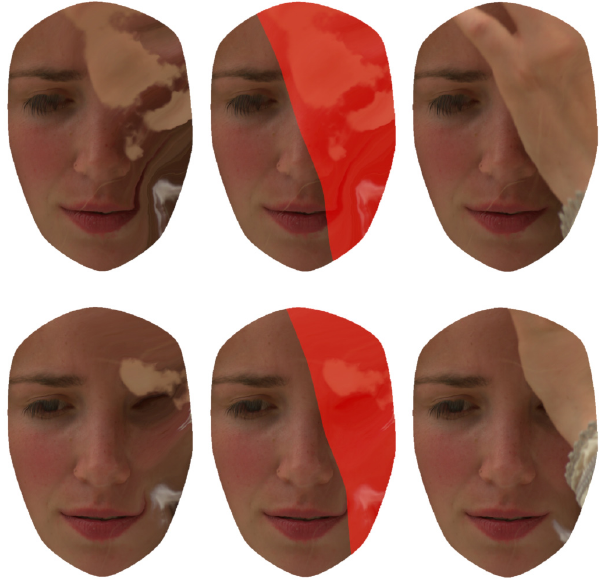
Fig. 14 Texture unwrap of samples 8 and 1 of the wife sequence, application of the influence brush in texture space, and resulting tracking